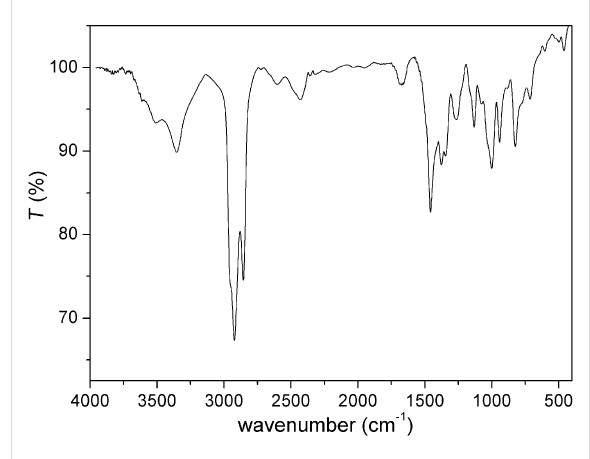
Figure 4: FTIR spectrum of Pt-DEA (Pt/DEA 1:1) nanoparticles (film).